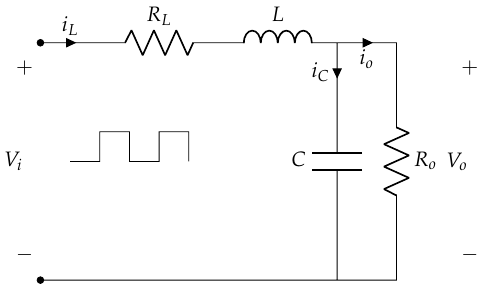
Figure 7. One-phase LC-filter for FSM-based